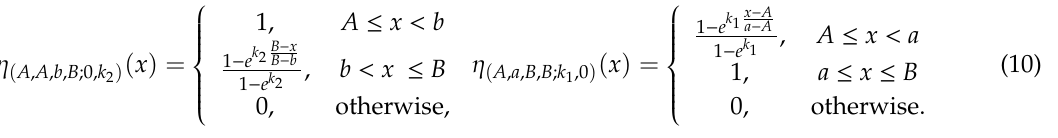
( x ) and µ ( x ) . Data from Example ( (cid:1876) ) . Data from Example 1. Figure 2. Representation of η ( ( 0,6,7,10 ) 0,6,7,10; − 2,1.5 ) ((cid:2868),(cid:2874),(cid:2875),(cid:2869)(cid:2868))